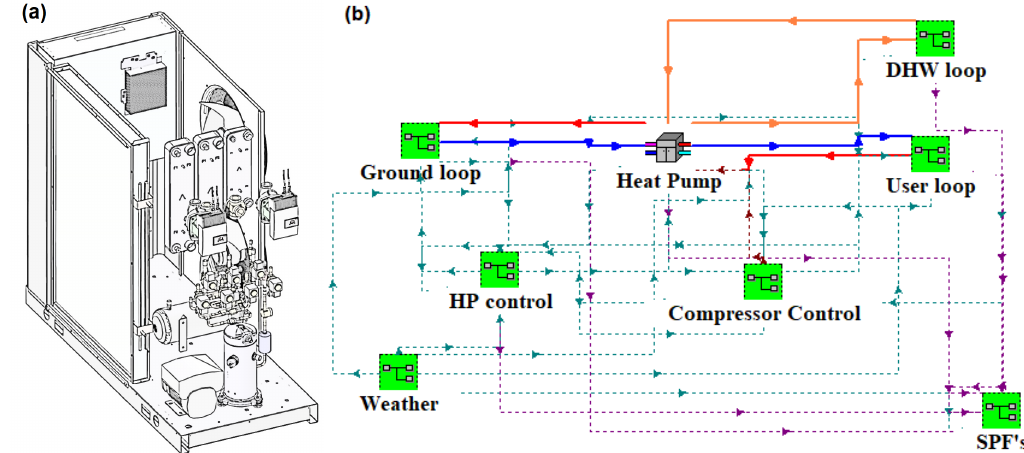
Figure 1. The DSHP ( a ) unit scheme and ( b ) system layout in TRNSYS.